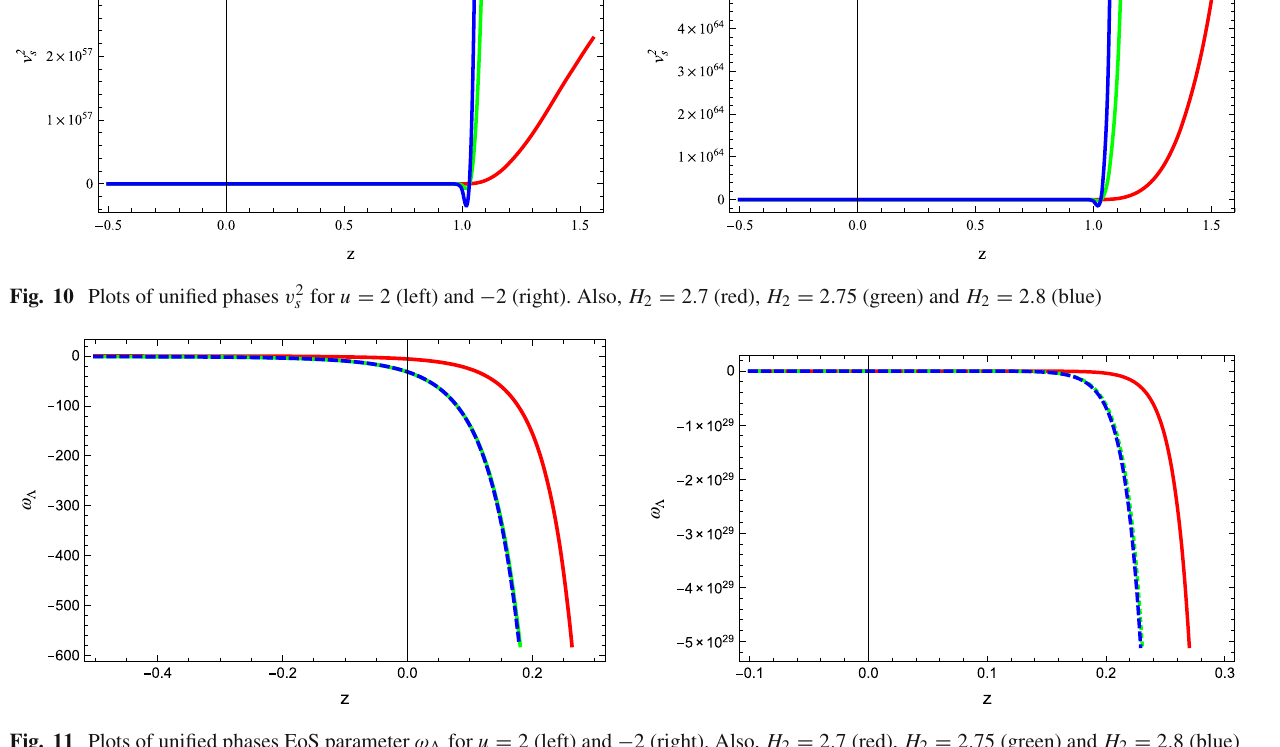
Fig. 11 Plots of unified phases EoS parameter ω (cid:3) for u = 2 (left) and − 2 (right). Also, H 2 = 2 . 7 (red), H 2 = 2 . 75 (green) and H 2 = 2 . 8 (blue)